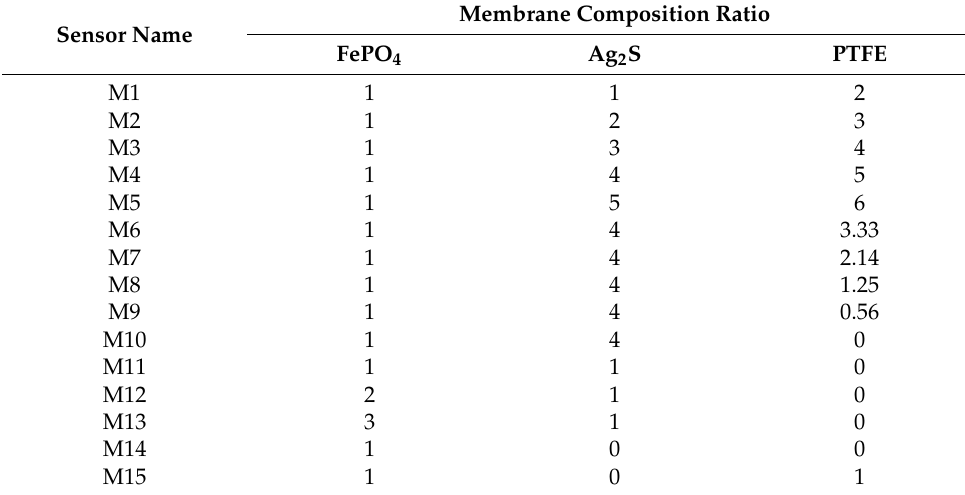
Table 1. List of all tested